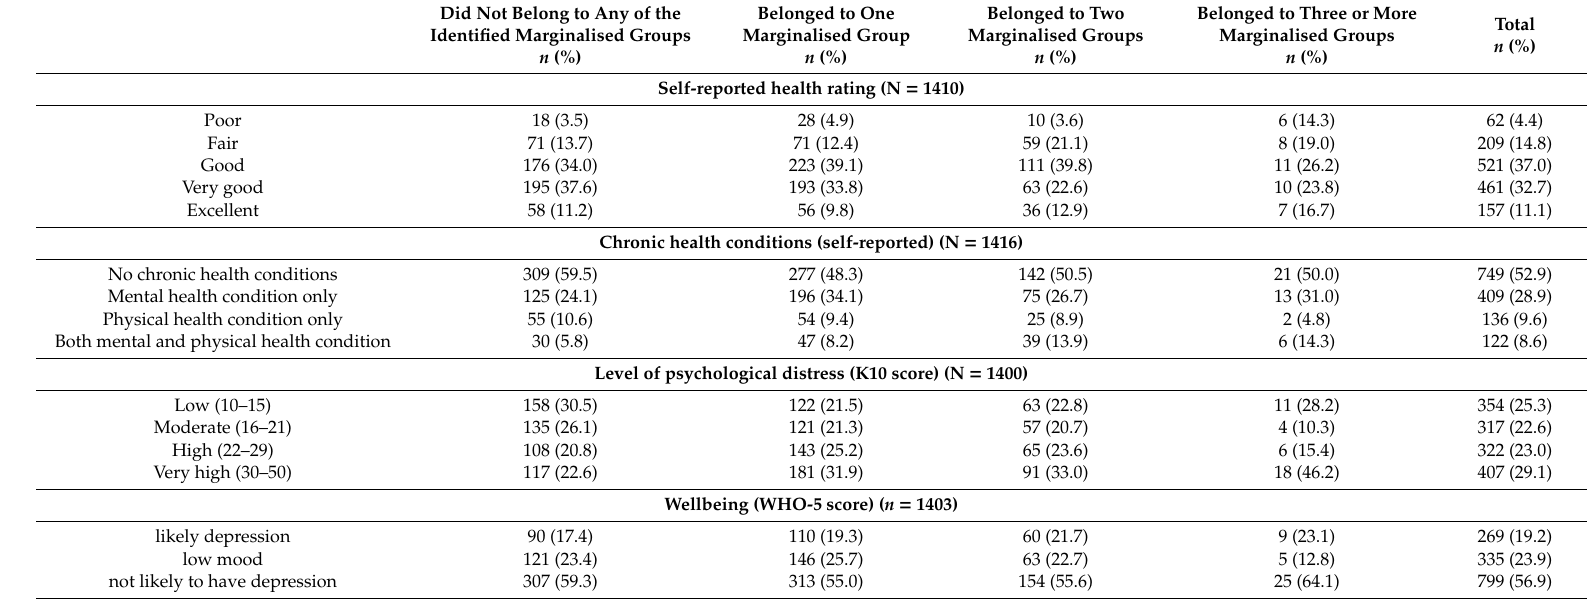
Table 2. Health status by number of marginalised